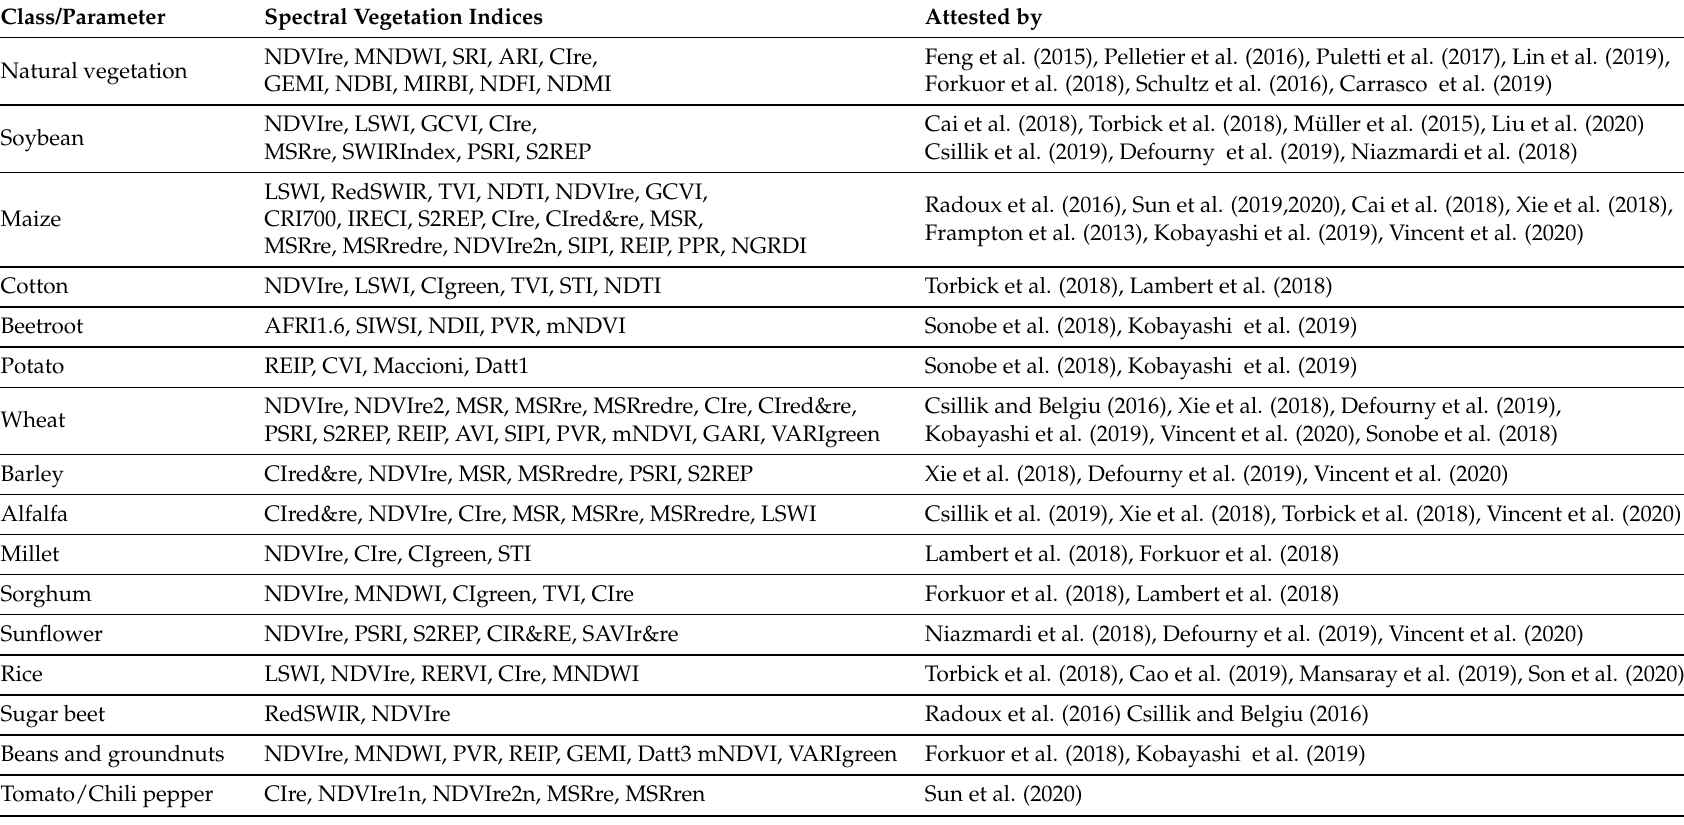
Table 3. Robustness of different and less frequent VIs to provide accurate mapping of different LULC